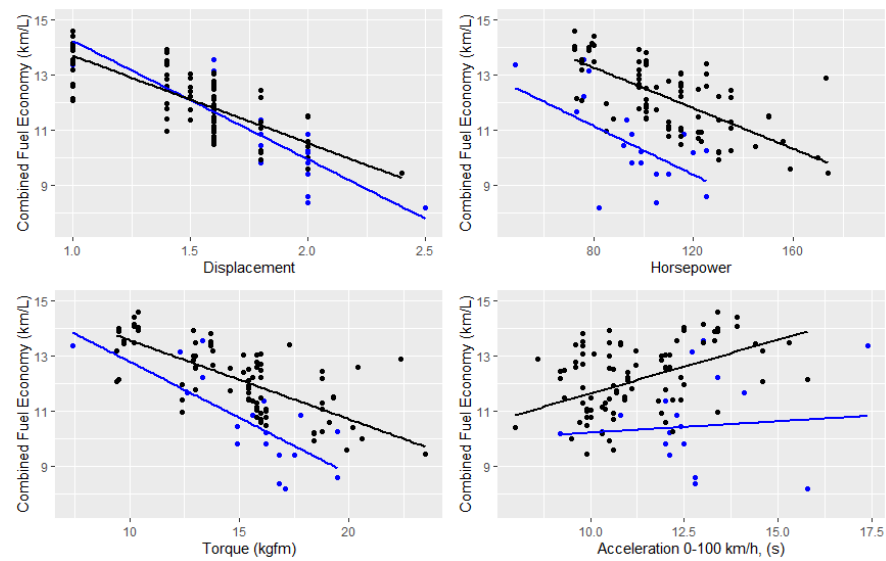
Figure 6. Performance parameters and FE (1990 in blue and 2018 in black).